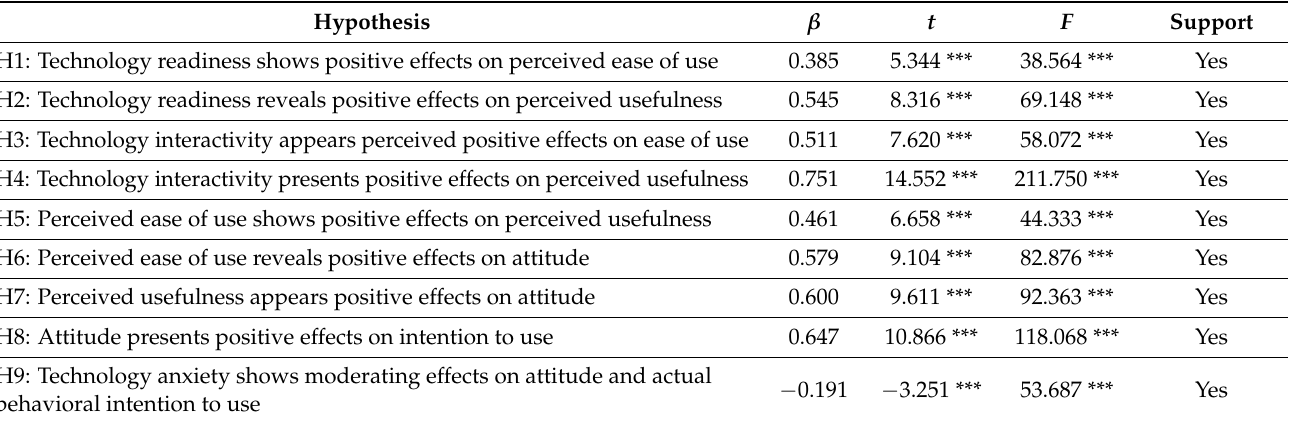
Table 5. Research hypothesis test result.